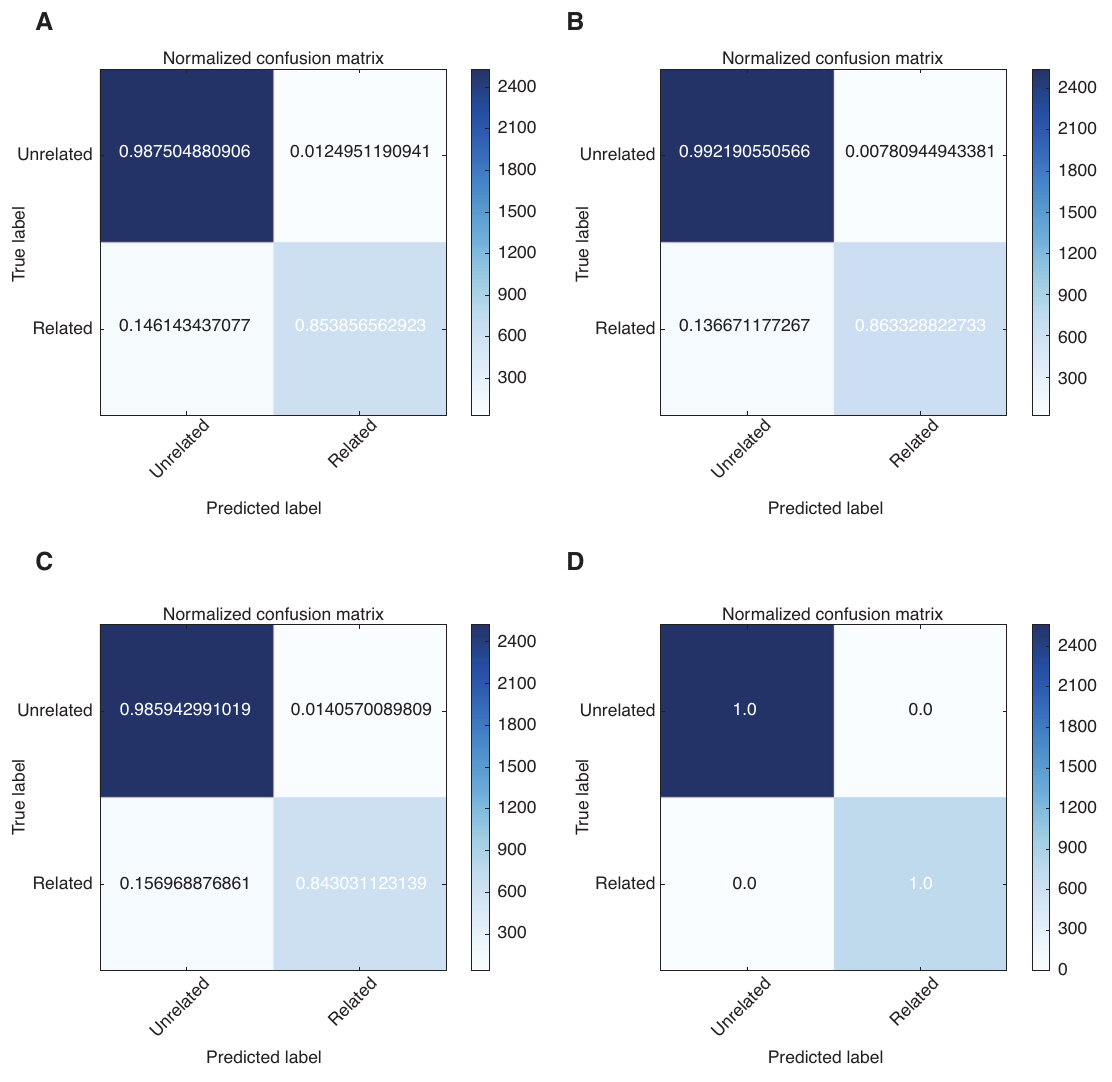
Figure 8: Normalized Confusion Matrix for (A) Adaboost, Random Forest (B), Decision Tree (C), and SVM (D)